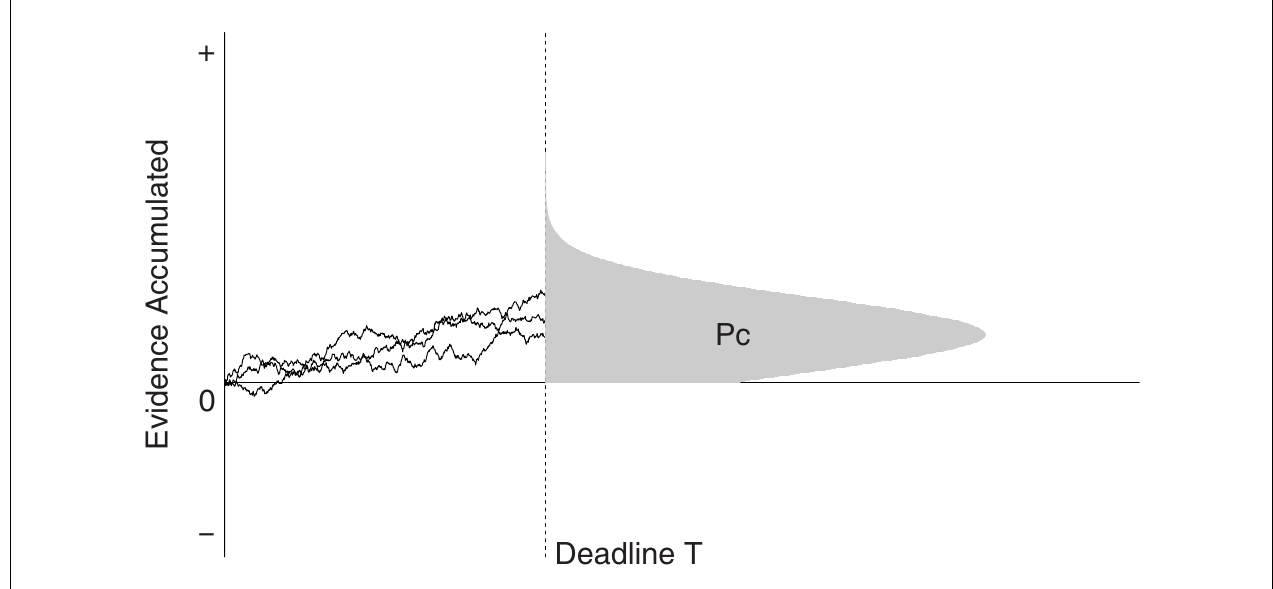
FIGURE 3 |The interrogation paradigm. At deadline T , decision makers choose a response alternative depending on the sign of the evidence accumulator.The shaded area under the distribution represents the proportion of correct answers.